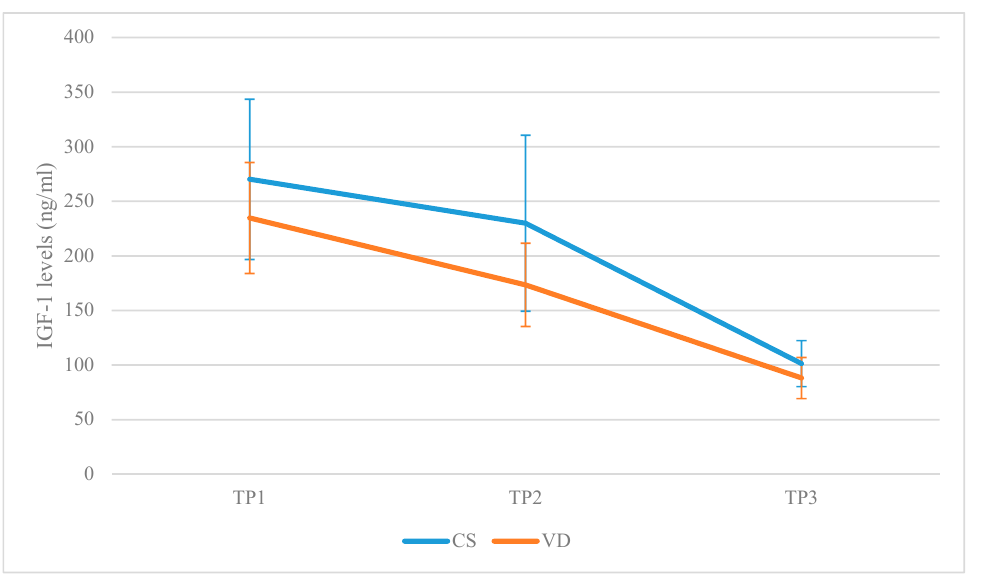
Figure 3. Insulin-like growth factor 1 (IGF-1 levels reported in the CSG and in the VDG, respectively, on each of the three separate time-points (TP1: Prior to labor; TP2: 120 min following placenta delivery; TP3: 48 h following placenta delivery).